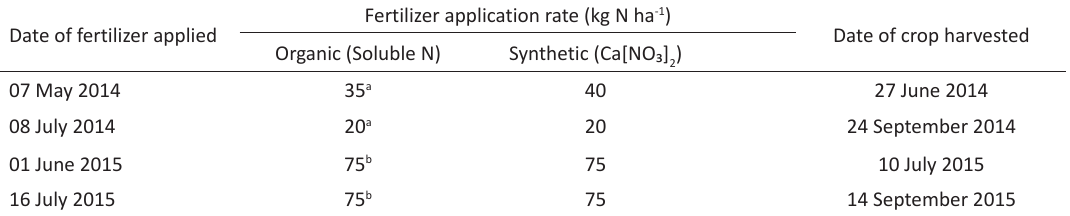
Date of crop harvested